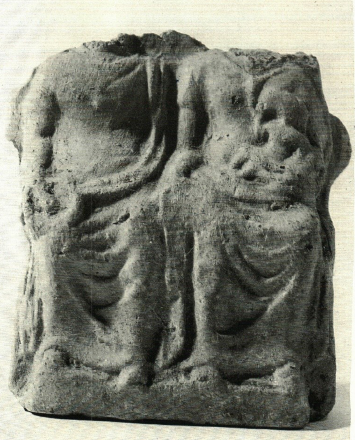
Figure 7. Rome (?) From Fridh-Haneson, “Le manteau”, 47, Fig. 54. One extremely interesting votive statuette comes from the Sanctuary of La Vignaccia (Caere, today Cerveteri) in Northern Latium (Fig. 8).28 It is a unicum : it represents two women, each suckling a baby, with an older child respectively on the left and right sides. Both women wear the chiton and the himation, which cover their heads. They have necklaces with pendants and a diadem. Each woman’s right hand rests on her right leg, while the babies are held in the left arm, likely being suckled with the left breast. The babies are